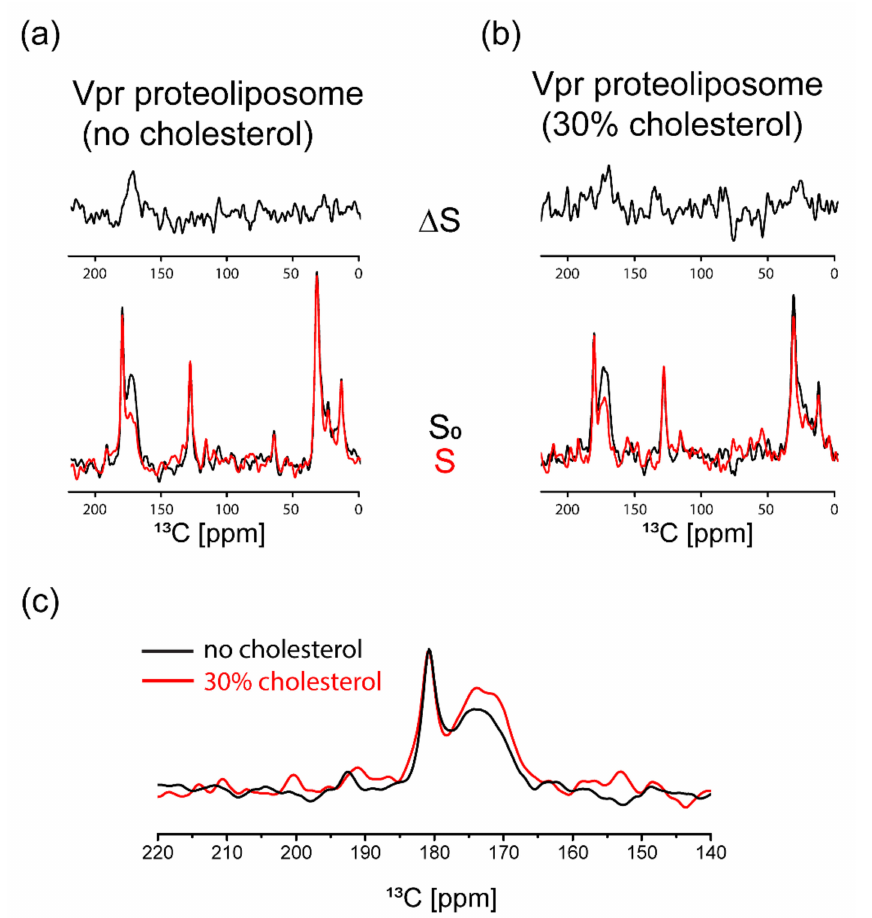
Figure 5. The 13 C{ 31 P} REDOR NMR spectra of [1- 13 C] cysteine selective labeled Vpr embedded in liposomes. ( a ) 13 C{ 31 P} REDOR NMR spectra of [1- 13 C] cysteine selective labeled Vpr embedded in DOPG liposomes. ( b ) 13 C{ 31 P} REDOR NMR spectra of [1- 13 C] cysteine selective labeled Vpr embedded in liposomes (cholesterol: DOPG lipids = 30:70). ( c ) The comparison of the S 0 spectra of these two samples.